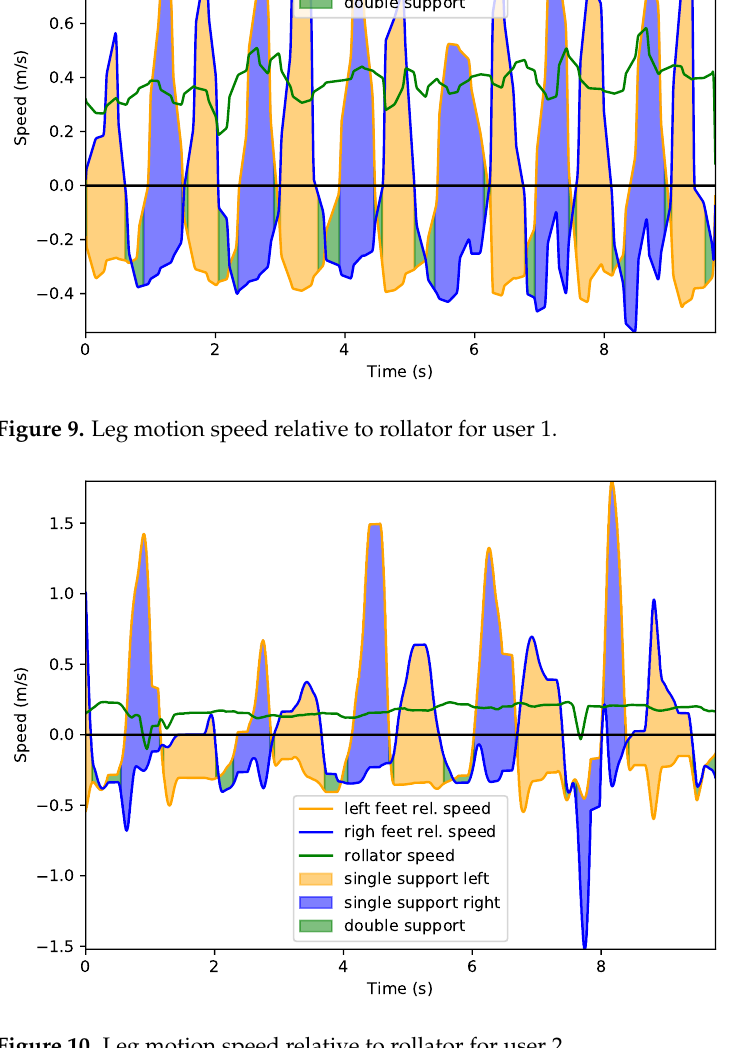
Figure 10. Leg motion speed relative to rollator for user